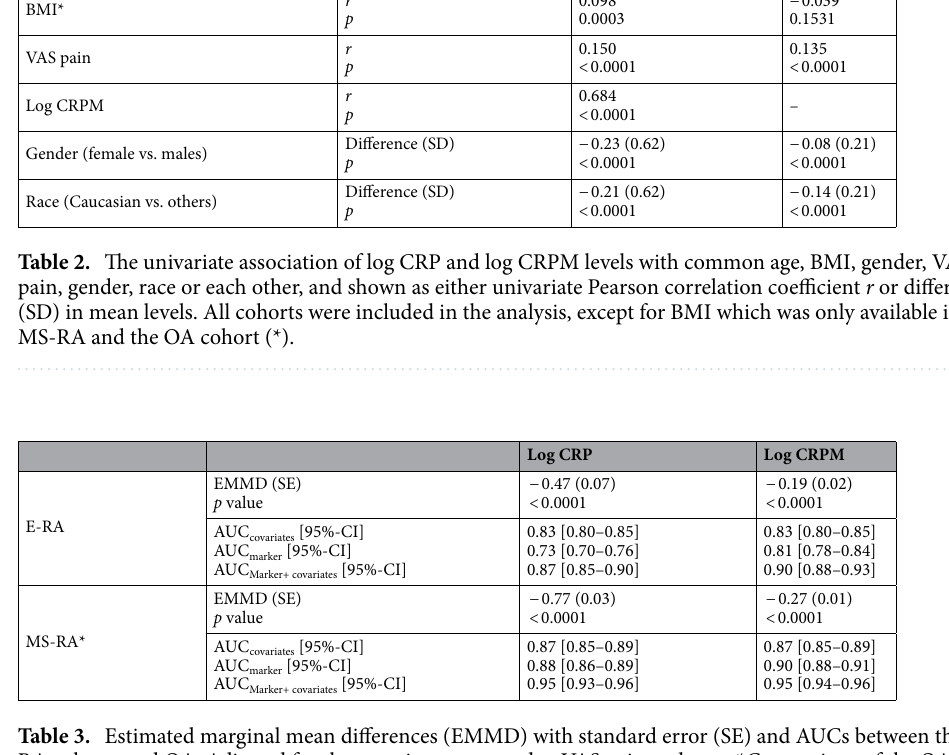
Table 3. Estimated marginal mean differences (EMMD) with standard error (SE) and AUCs between the RA cohorts and OA. Adjusted for the covariates age, gender, VAS pain and race. *Comparison of the OA with MS-RA cohort was furthermore adjusted for